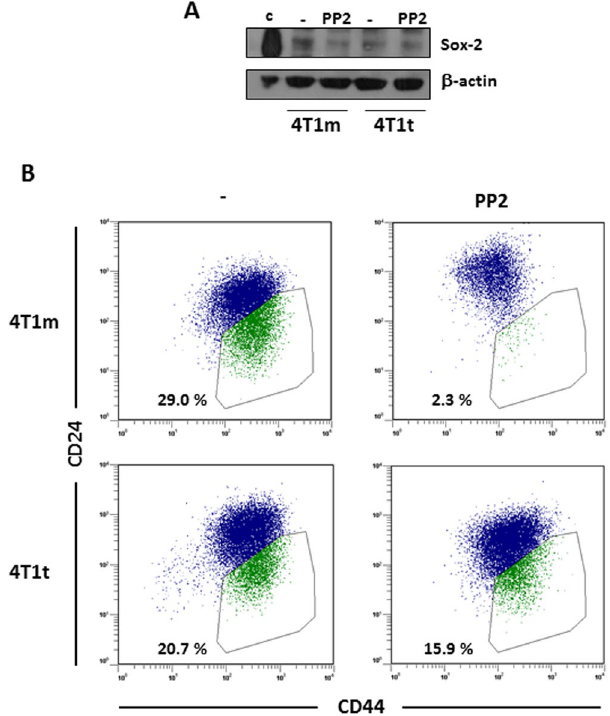
Figure 6. Pharmacological inhibition of Src reduces stemness. ( A ) Western blot analysis of Sox2 expression in 4T1m and 4T1t cells untreated or treated with PP2. Due to the high background observed in the blot, a positive control with a lysate of 293 T cells overexpressing Sox2 (c) was included. β -actin was used as a control for protein loading. ( B ) Flow cytometry analysis of the cell-surface markers CD44 and CD24 in 4T1m and 4T1t cells untreated or treated with PP2. The percentage of CD44 high /CD24 med/low cell subpopulation is indicated. A representative experiment out of two is